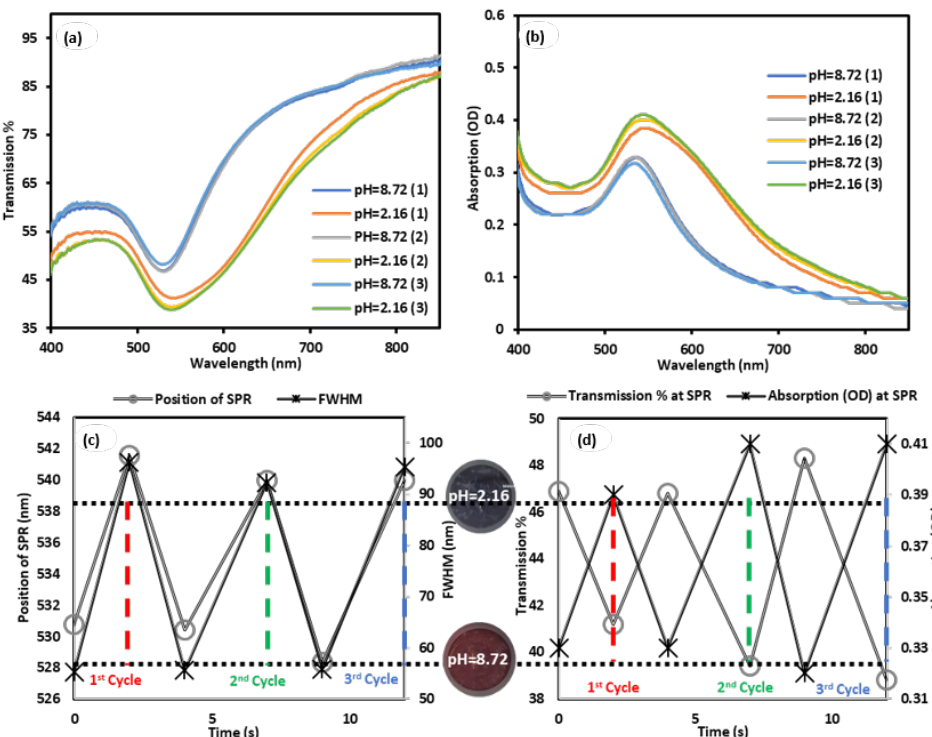
Figure 7. Repeatability and time response of the GNPs-MPA doped gels: ( a ) Transmission and ( b ) absorption of the doped gels over three cycles switching between acidic (pH 2.16) and basic (pH 8.72) conditions (the number next to each curve denotes the number of the cycle). Time response of ( c ) SPR position and FWHM and ( d ) transmission and absorption values at SPR over three cycles. Images of the gel at the two distinct pHs are shown between ( c , d ).